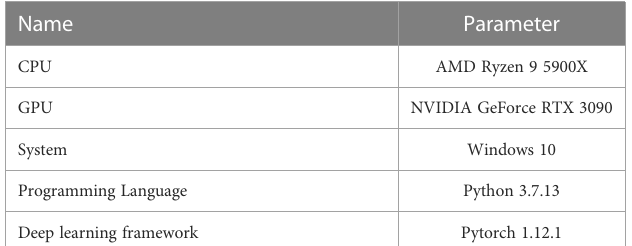
TABLE 2 Experimental con fi